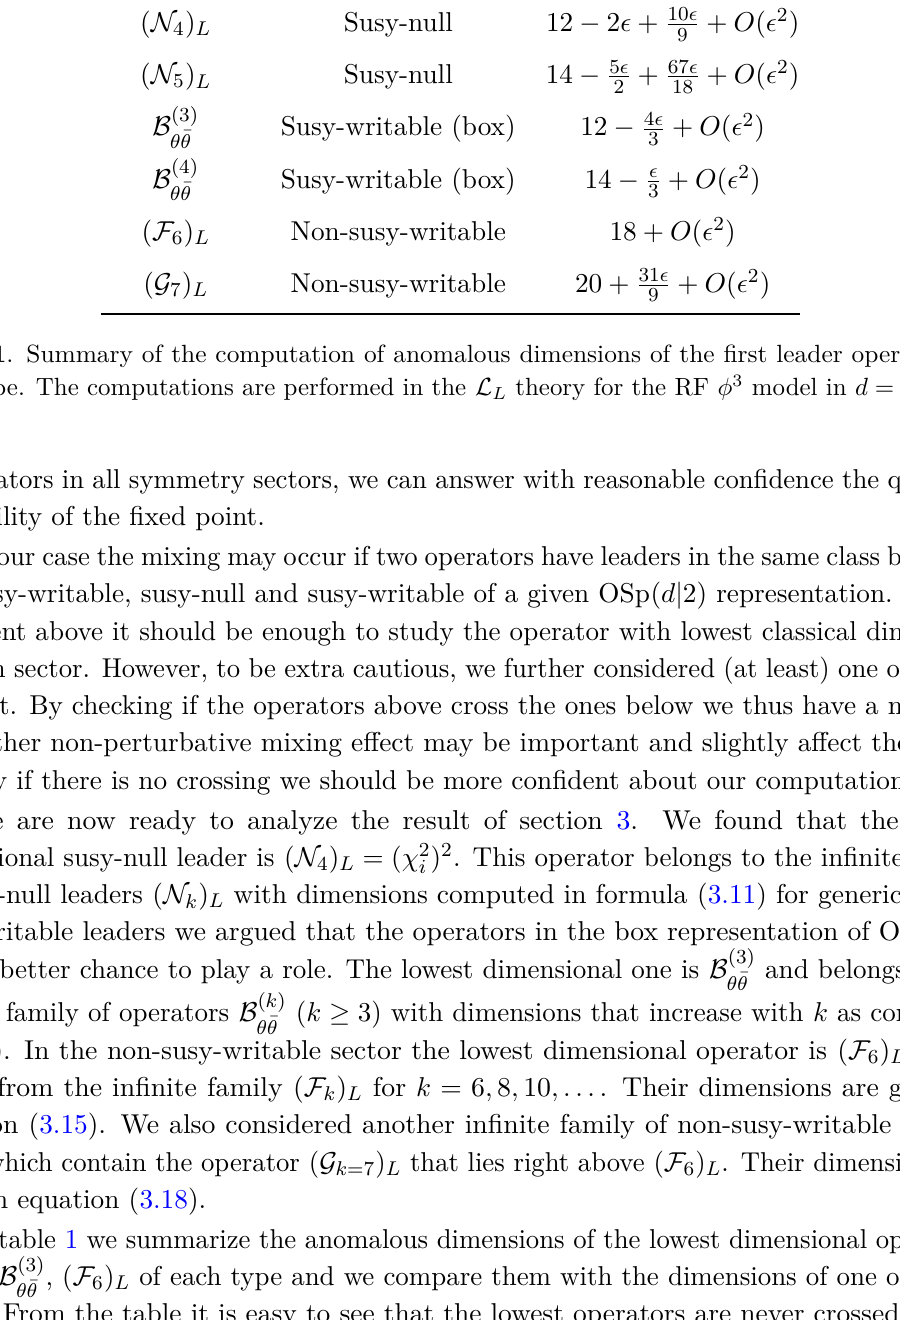
theory for the RF φ 3 model in d = 8 − (cid:15) . L